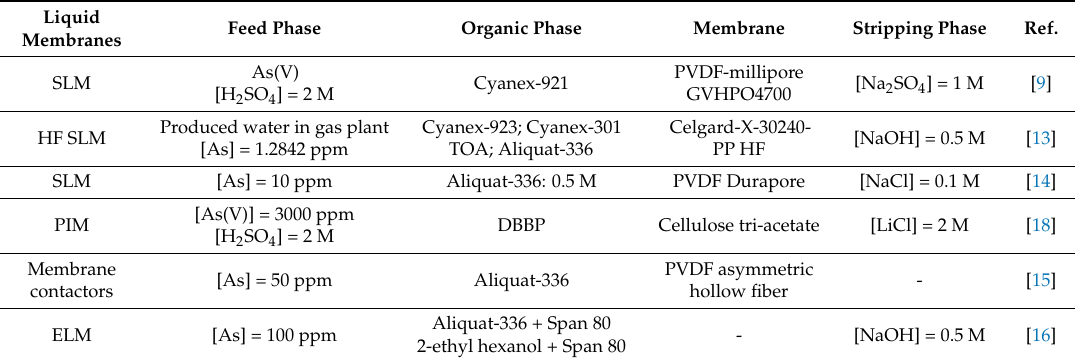
Table 1. Removal of arsenic by liquid membrane